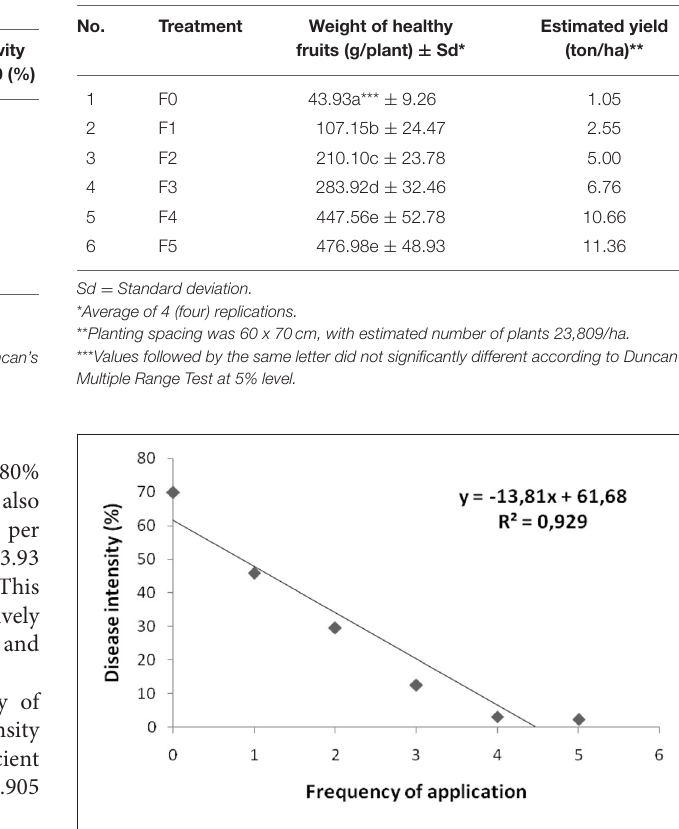
FIGURE 1 | Relationship between frequency of application of formulation F6 with the disease intensity on chili pepper cultivar Cabe Besar .